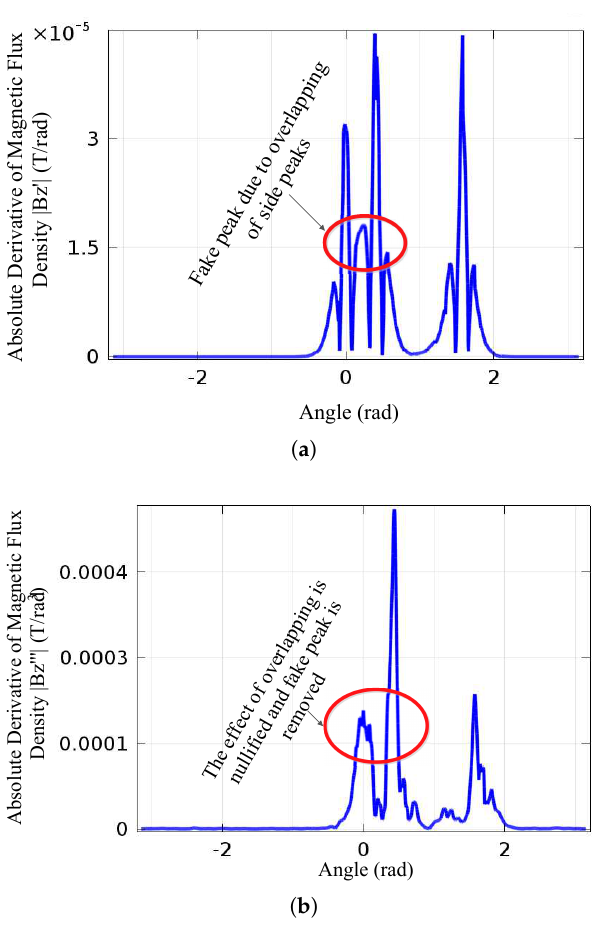
Figure 8. ( a ) 1st order derivative of magnetic flux density. Side peaks corresponding to b 1 and b d have overlapped, fake peak appears which represents the presence of another branch between b 1 and b d . ( b ) 3rd order derivative of magnetic flux density. The main peak and side peak width is reduced to an extent that the effect of overlapping is